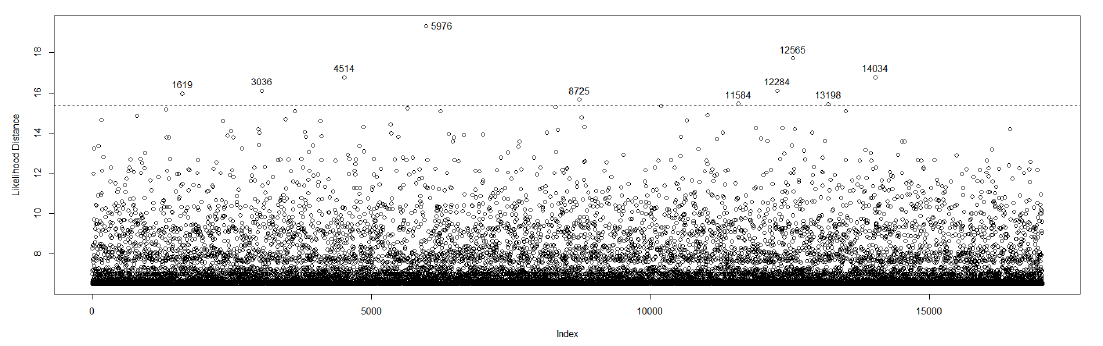
Figure 6. Likelihood